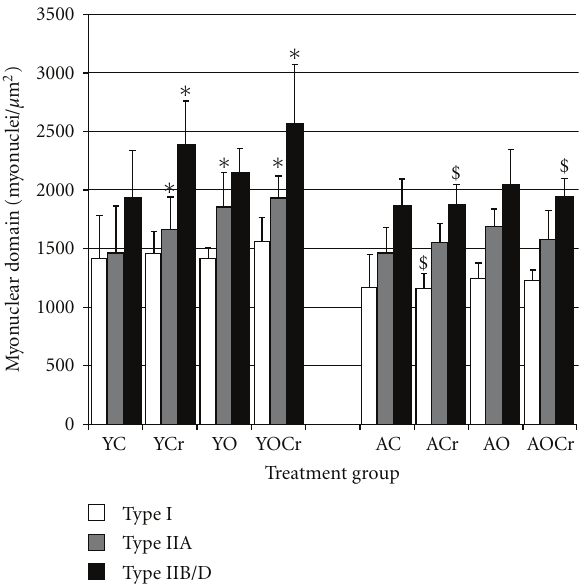
Figure 3: Myonuclear domain size for plantaris muscle in young and aging animals for all treatment groups. Open bars are type I fibers, grey bars are type IIA fibers, and closed bars are IID/B fibers. Data are presented as mean ± SD. ∗ Significantly di ff erent than control treatment, within age group ( P < 0 . 05); # significantly di ff erent than creatine group, within age group ( P < 0 . 05); $ significantly di ff erent than same treatment in young rats ( P < 0 . 05). Units for myonuclear domain are myonuclei/um 2